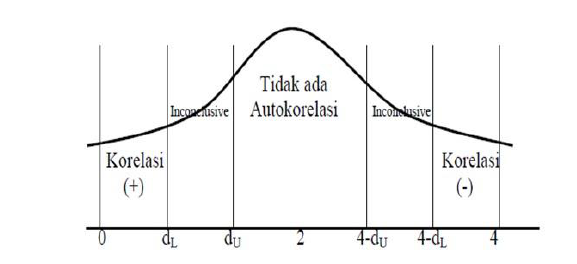
Figure 3. Area of autocorrelation test (Darmawan,